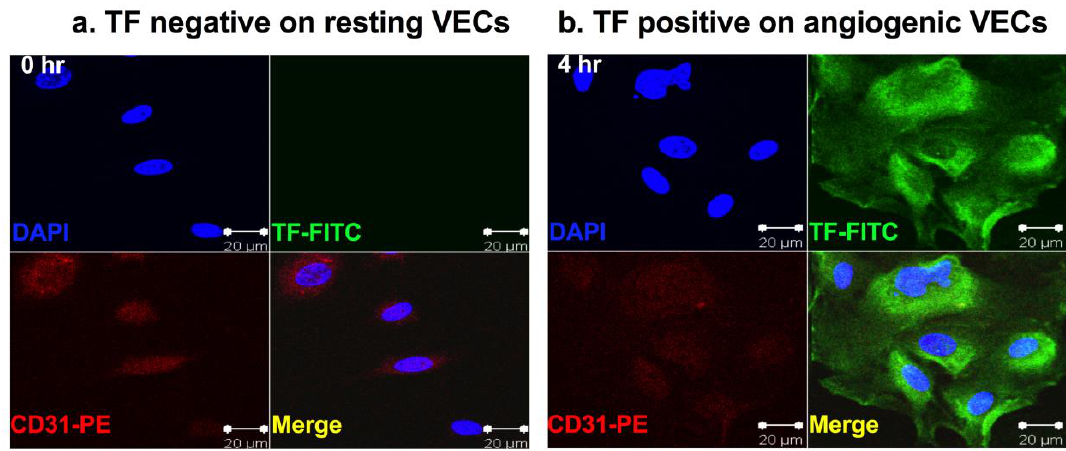
Figure 1. Tissue factor (TF) is an angiogenic specific receptor. Representative confocal imaging of TF (green) and endothelial marker CD31 (red) expression on human microvascular endothelial cells (HMVEC) before 0-hour (0 h) as a normal resting vascular endothelial cell (VEC) model ( a ) and 4 h (4 h) after vascular endothelial growth factor (VEGF) stimulation (4–6 h reaching peak expression) as an angiogenic VEC model ( b ). Cell nuclei were counterstained by DAPI (4′,6-Diamidino-2-Phenylindole, Dihydrochloride) (blue). Scale bars: 20 μm. Modified from ref. [15].